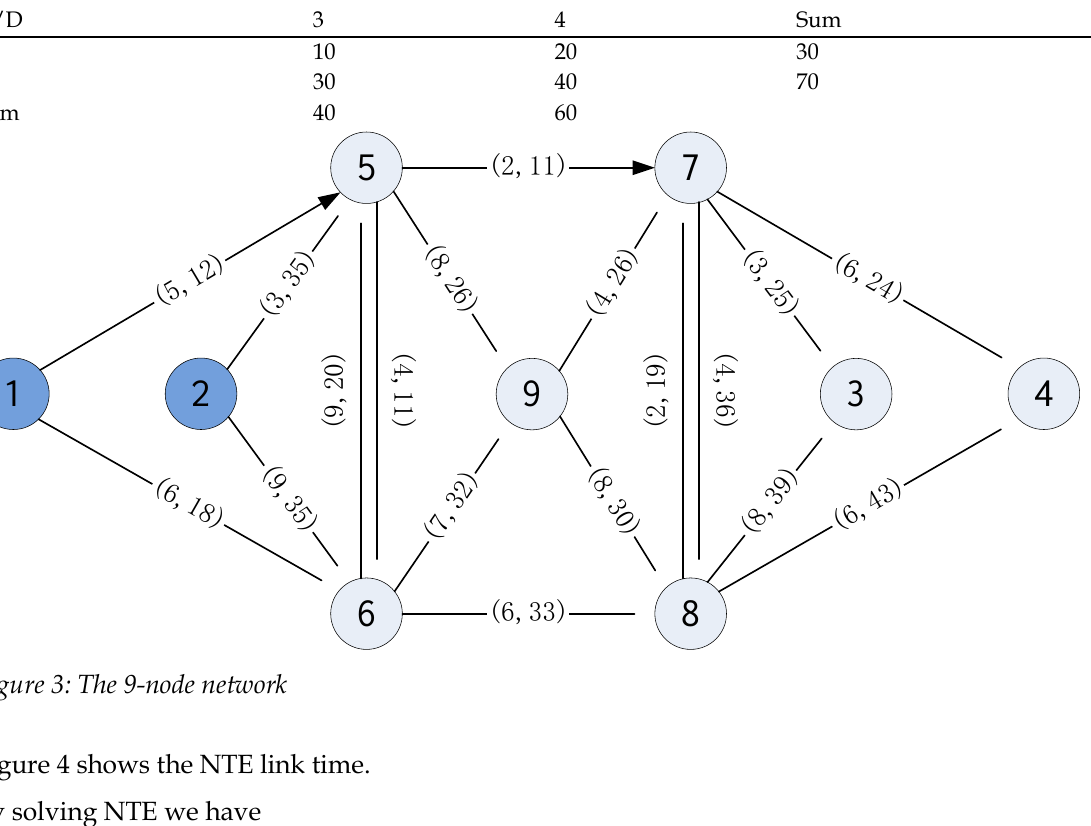
Table 1: OD matrix